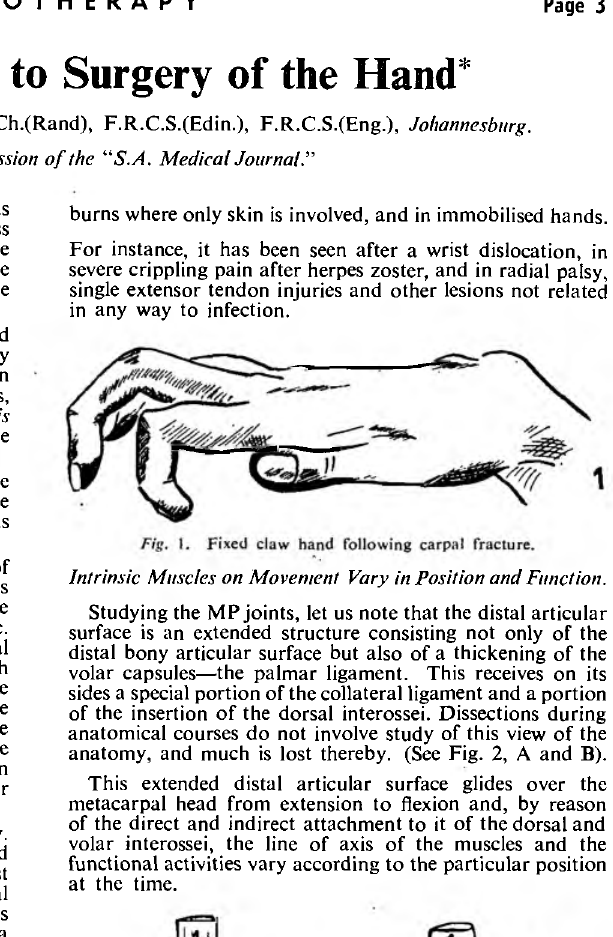
Fig. 2. (A) Right index finger, distal articular structures. (B) Middle finger distal articular structures. J, Extensor tendon. 2, Transverse fibres of aponeurosis. 3, Proximal articular surface of phalanx, 4, Dorsal interosseous muscle. 5, Volar interosseous muscle. 6, Fibrous connection to palmar fascia and fibrous flexor sheath. 7, Collateral ligaments. 8, Portion of collateral ligament forming palmar ligament. 9, Lumbrical muscle. 10, Deep transverse palmar ligament. In extension the dorsal interossei can abduct, but otherwise they tend to pull the articular surfaces together and jam the palmar ligamant against the metacarpal